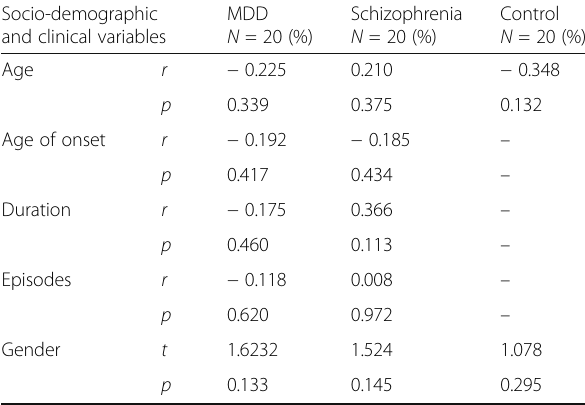
Table 3 Association of demographic and clinical variables associated with low serum vitamin D among the study sample Socio-demographic and clinical